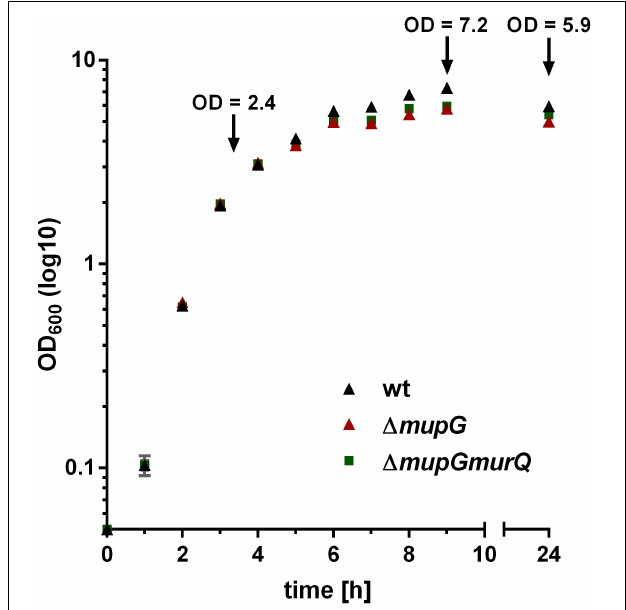
FIGURE 1 | Growth kinetics of wild type and peptidoglycan recycling mutants in LB medium. S. aureus wild type (wt, black triangles), (cid:49) mupG mutant (red triangle), and (cid:49) mupGmurQ (green squares) cells were grown in LB medium under constant shaking and the optical density was monitored at 600 nm (OD 600 ) up to 24 h. Experiment was performed in triplicates and data were presented in GraphPad Prism 6 as mean ± SD. Arrows indicate the time when samples were taken for the generation of cytosolic fractions in different growth